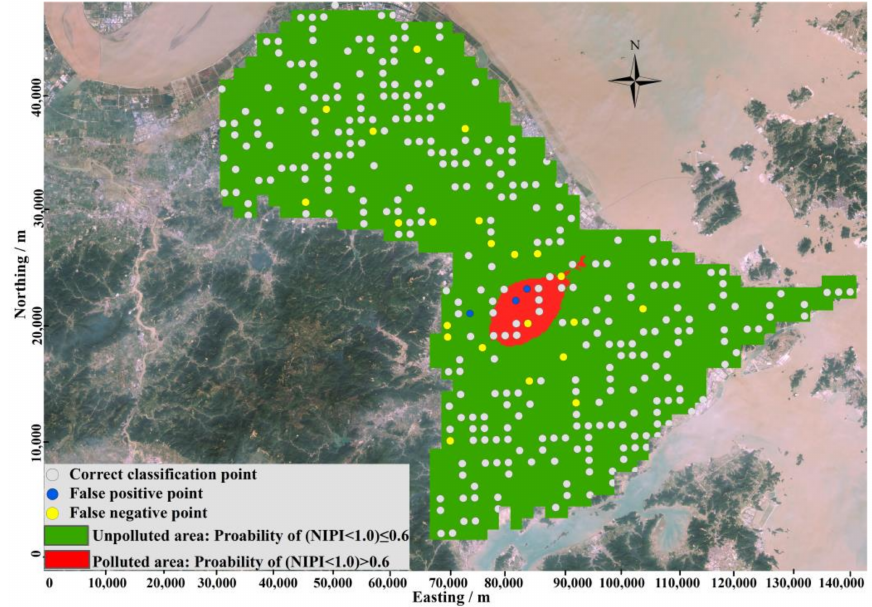
Figure 6. Delineation of composite heavy metal pollution according to pollution